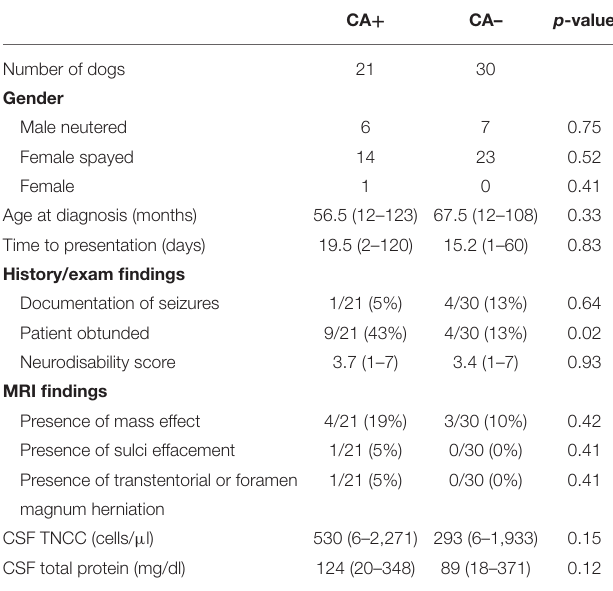
TABLE 1 | Patient variable at initial